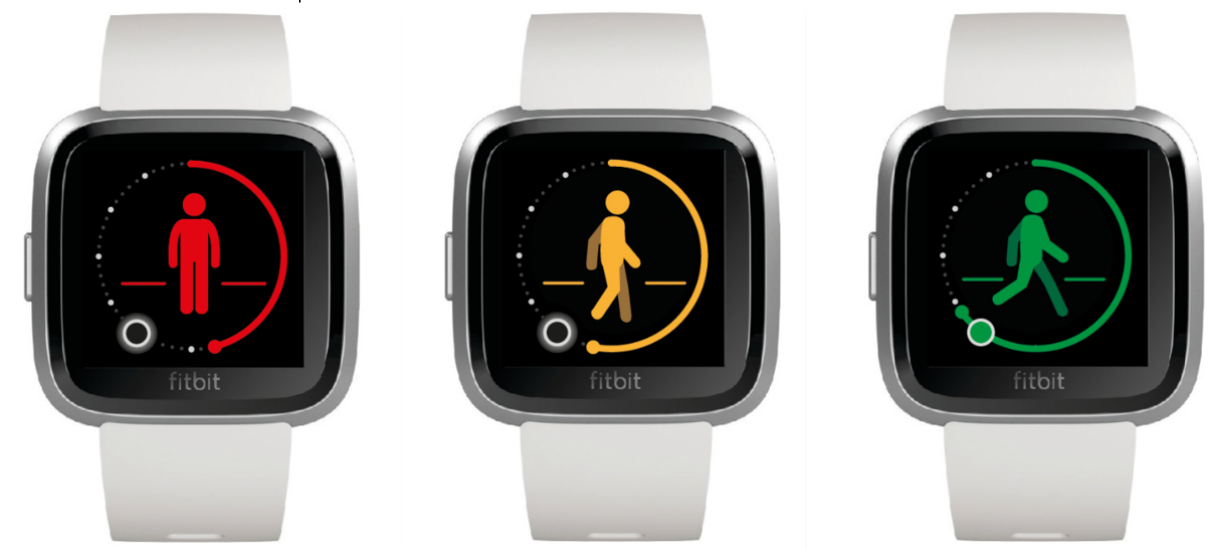
Figure 2. Smartwatch with built-in step